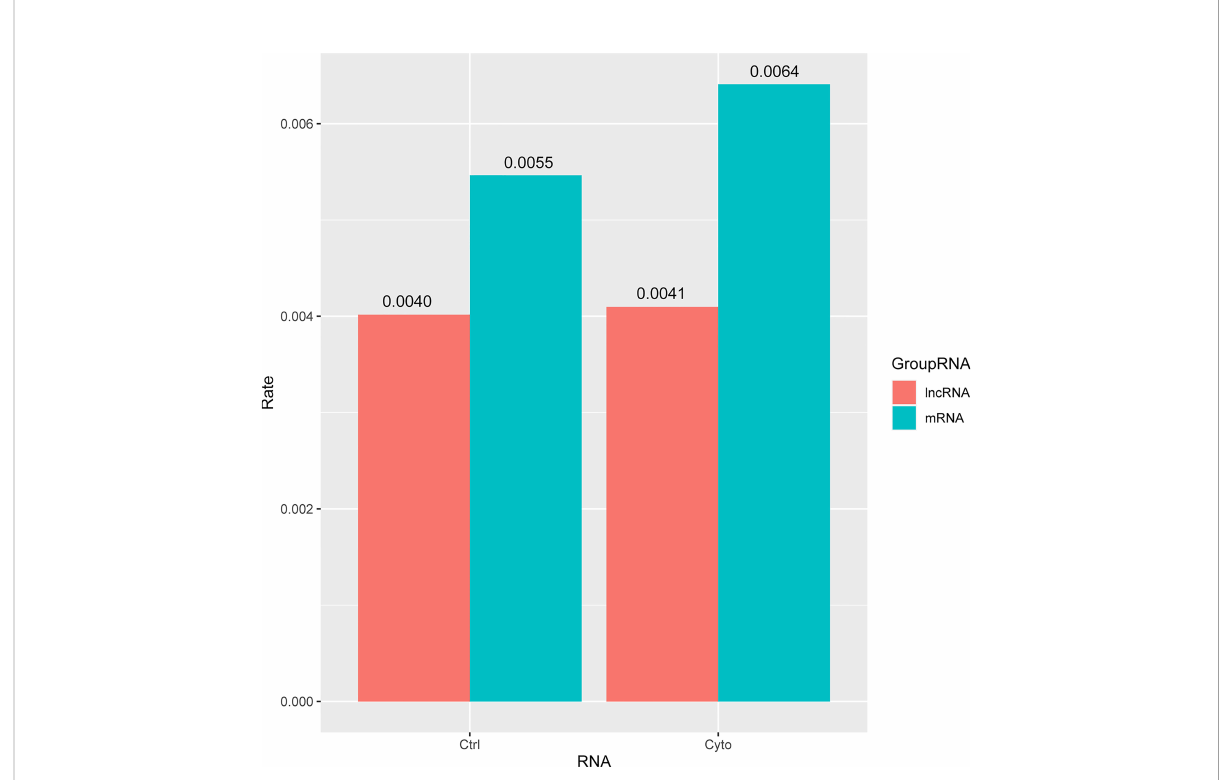
FIGURE 4 The ratio of differential lncRNAs and mRNAs in the two networks of exosomes. ctrl: Function enriched for mRNAs in network without cytokines stimulation; cyto: Function enriched for mRNAs in network with cytokines